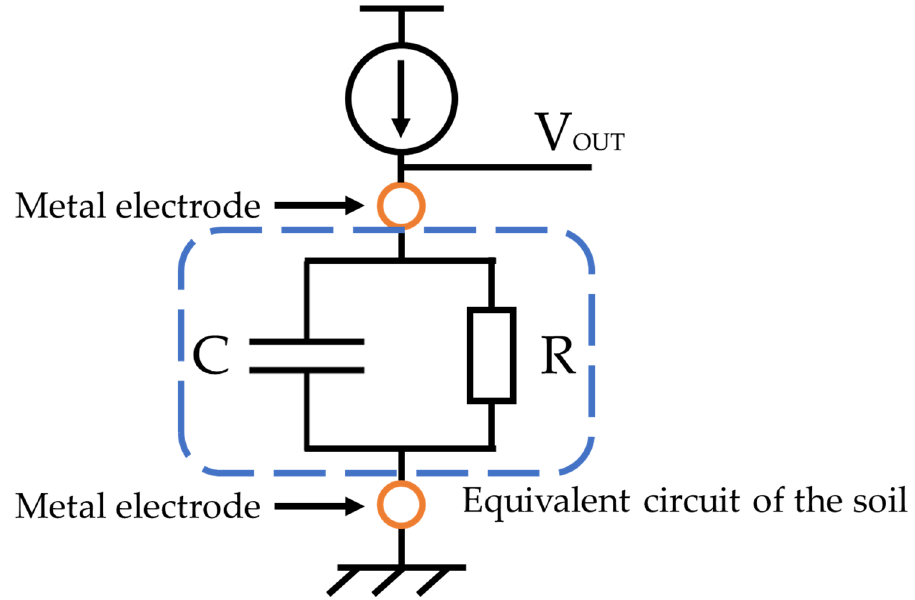
Figure 6. Equivalent circuit when a current is applied to the soil.